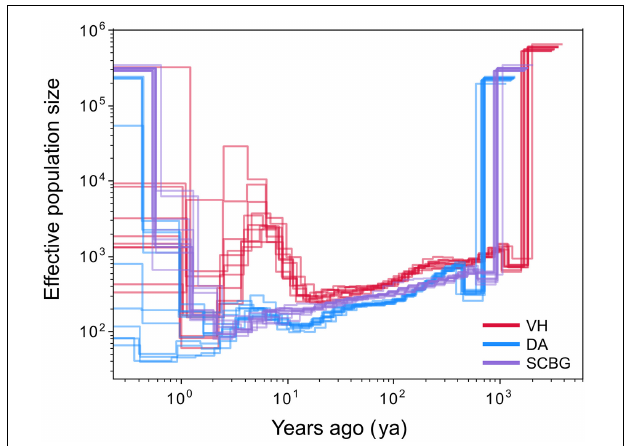
FIGURE 4 | Demographic history of island (DA) and continental (VH and SCBG) populations. The demographic history is reconstructed from the seven longest contigs by multiple sequential Markovian coalescence (MSMC) model. Inferred fluctuations in effective population size (Ne) from 1,000 years ago (ya) to the present based on the 0.25-year generation time and 2.8 × 10 − 8 per site per generation mutation rate assumptions. Lines represent each one of ten independent estimates, in which four samples from one population were chosen randomly. Red, blue, and purple present populations from Vinh Yen, Vietnam (VH); Hainan island, China (DA); and Guangzhou, China (SCBG),